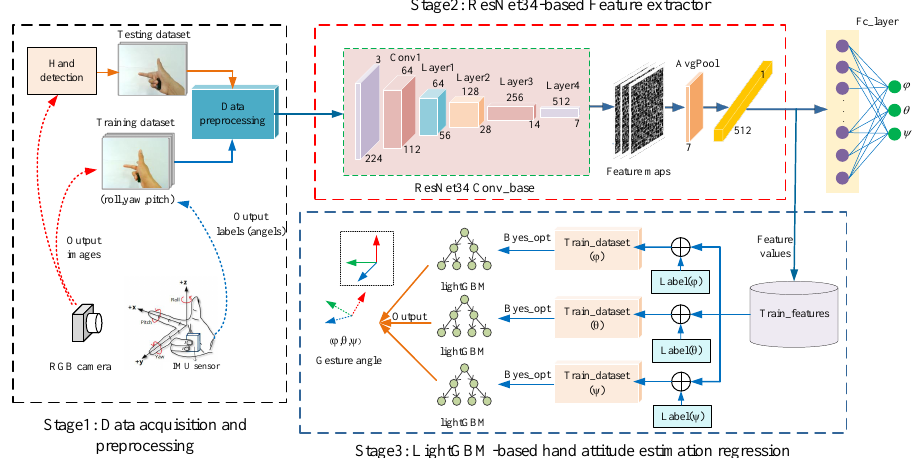
Figure 3. Hand attitude estimation process for each monocular